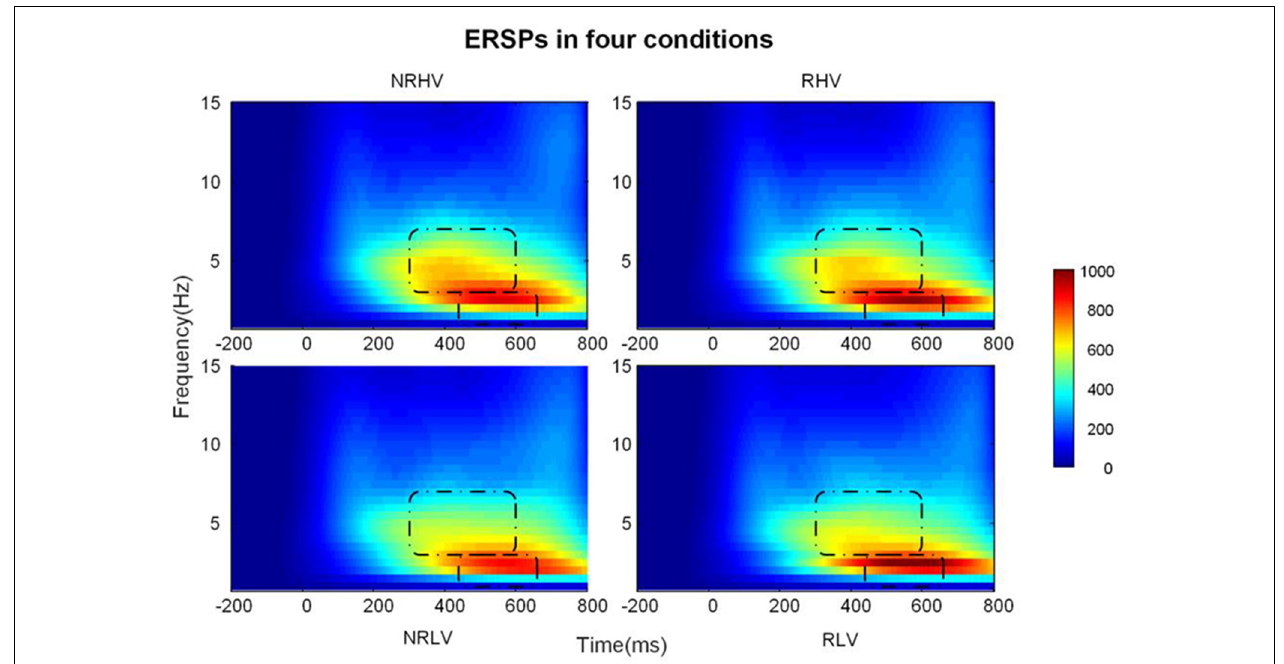
FIGURE 5 | The time-frequency representations in the four conditions averaged over